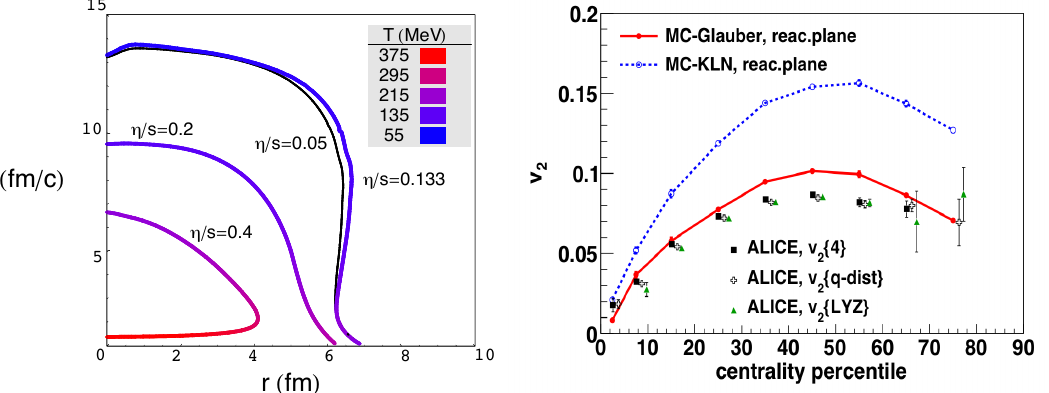
Figure 15. Left : Location of freeze-out surfaces for central Au + Au collisions [108]; Right : The centrality dependence of the elliptic flow of charged hadrons from Pb–Pb collisions at √ s = 2.76 TeV [298]. The ALICE data are from Ref. NN